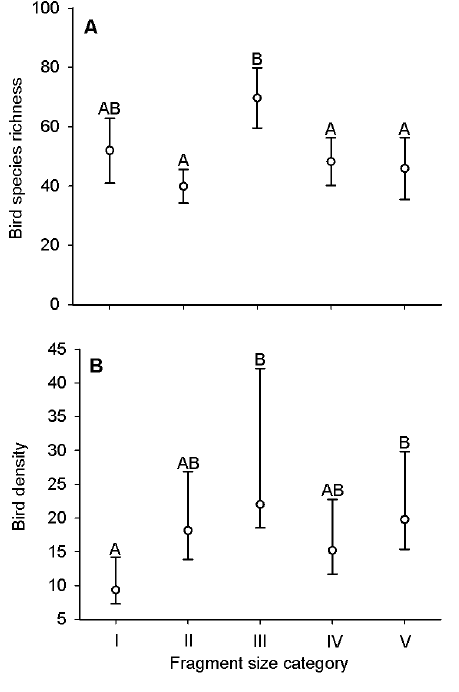
Fig. 1 . Variation in avian diversity among five cloud forest size categories in central Veracruz for (A) estimated avian species richness with 84% confidence intervals and (B) sum of estimated bird density from three forest dependency subgroups, with mean 84% confidence intervals, for each cloud forest fragment size category. Letters above values for each fragment size category indicate statistically significant differences among